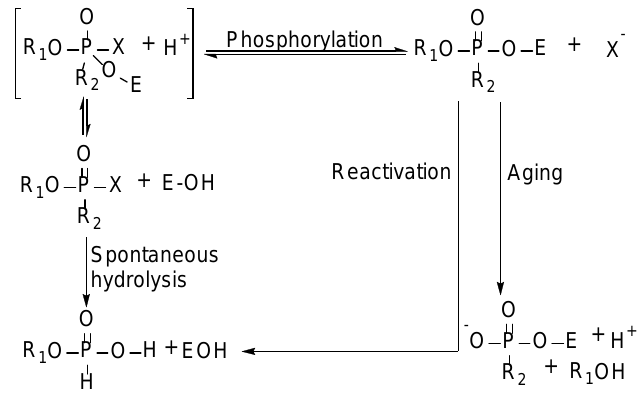
Figure 3. Mechanism of the inhibition of cholinesterase by OPs.